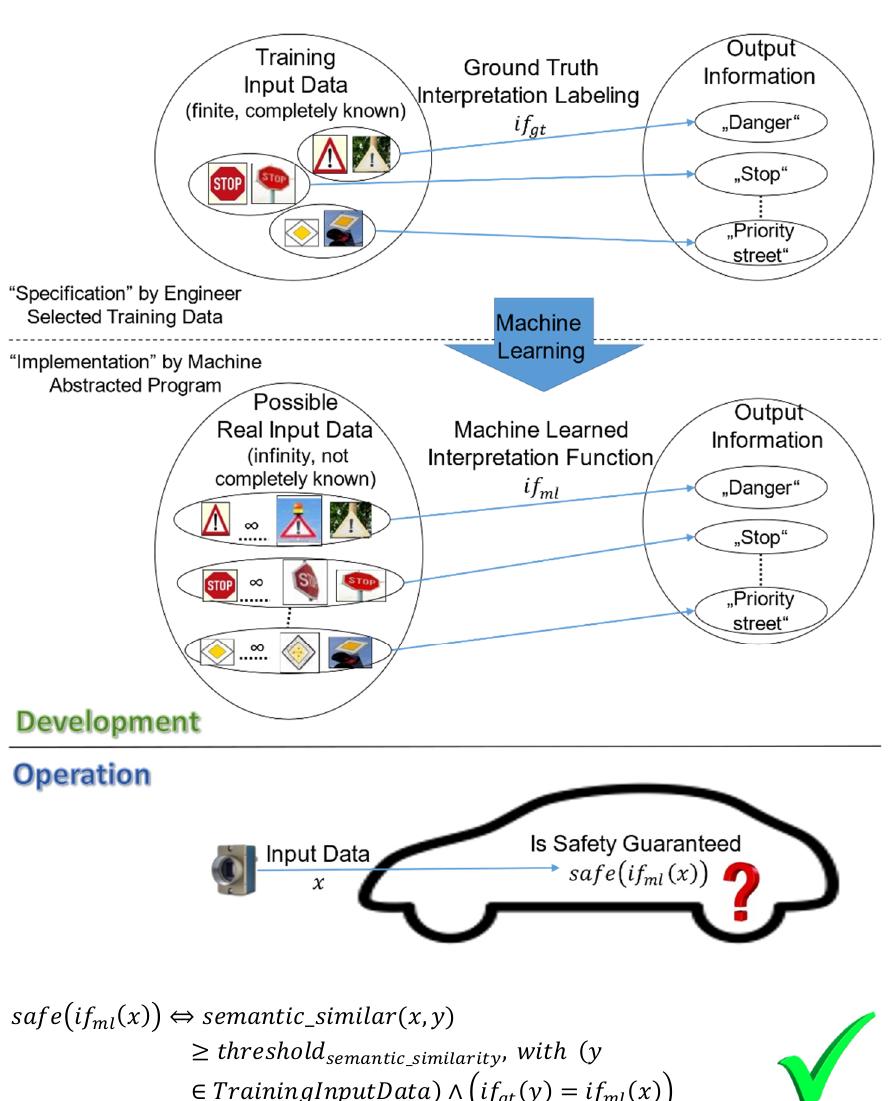
Figure 1. Operation time check of dependability requirements.